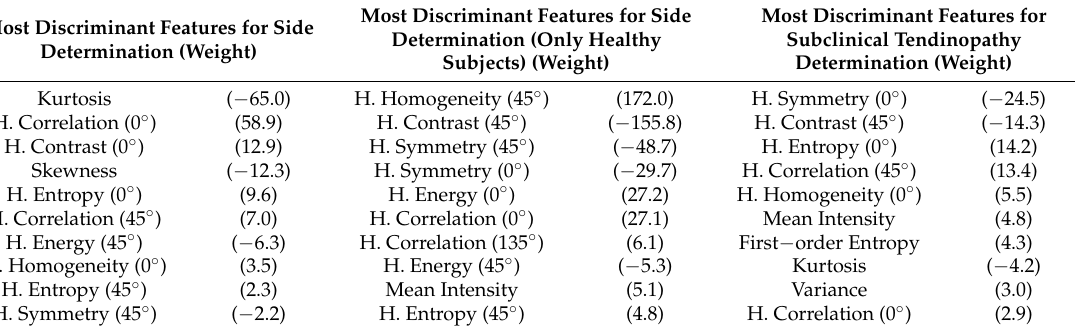
Table 4. Image features that were the most discriminant between dominant and non-dominant side (all subjects and only healthy subjects) and to determine subclinical